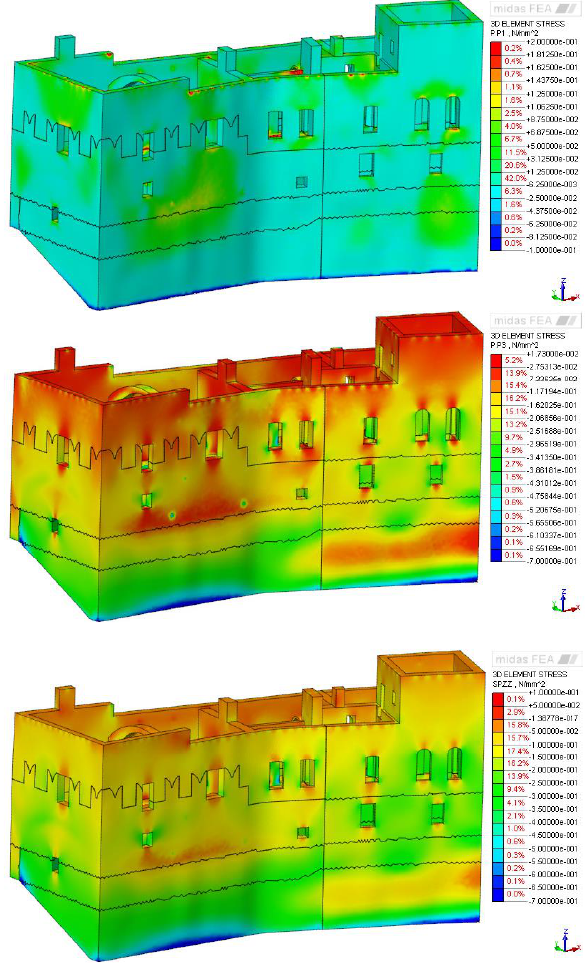
Fig. 8. Stress after simulation via alveolar mesh derived from BIM: (top) first principal stress; (middle) third principal stress; (bottom) vertical